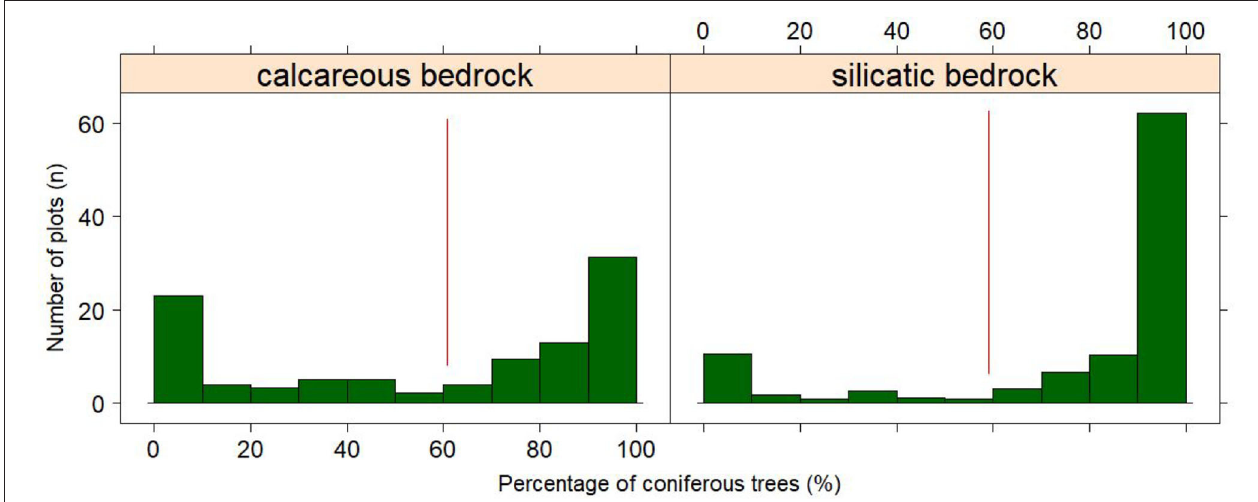
FIGURE 1 | Distribution of tree species combinations in Austria on calcareous vs. silicatic bedrock. The vertical red reference lines indicate the pragmatically defined threshold between mixed-deciduous and coniferous